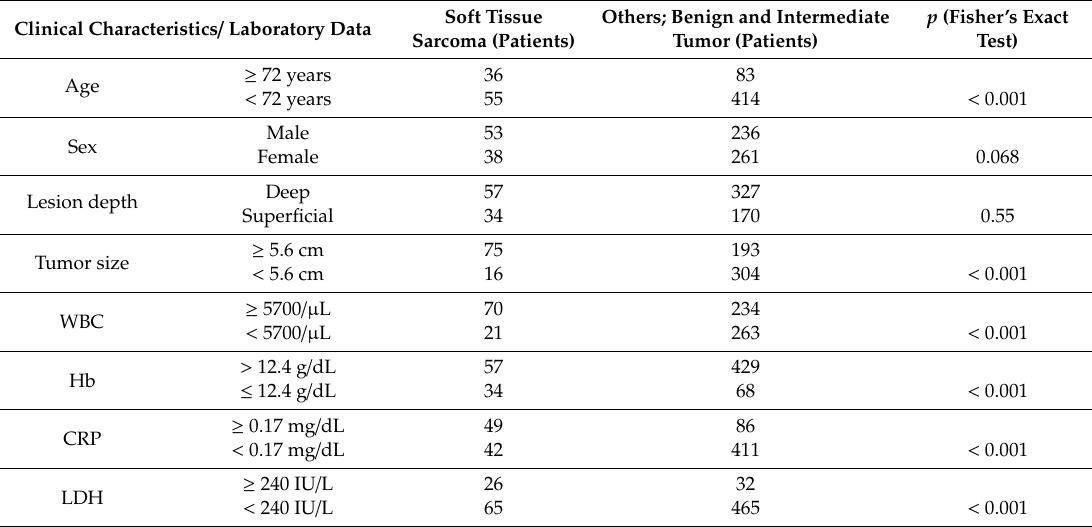
Table 4. The association between diagnosis and clinical characteristics or laboratory data. Clinical Characteristics / Laboratory Data